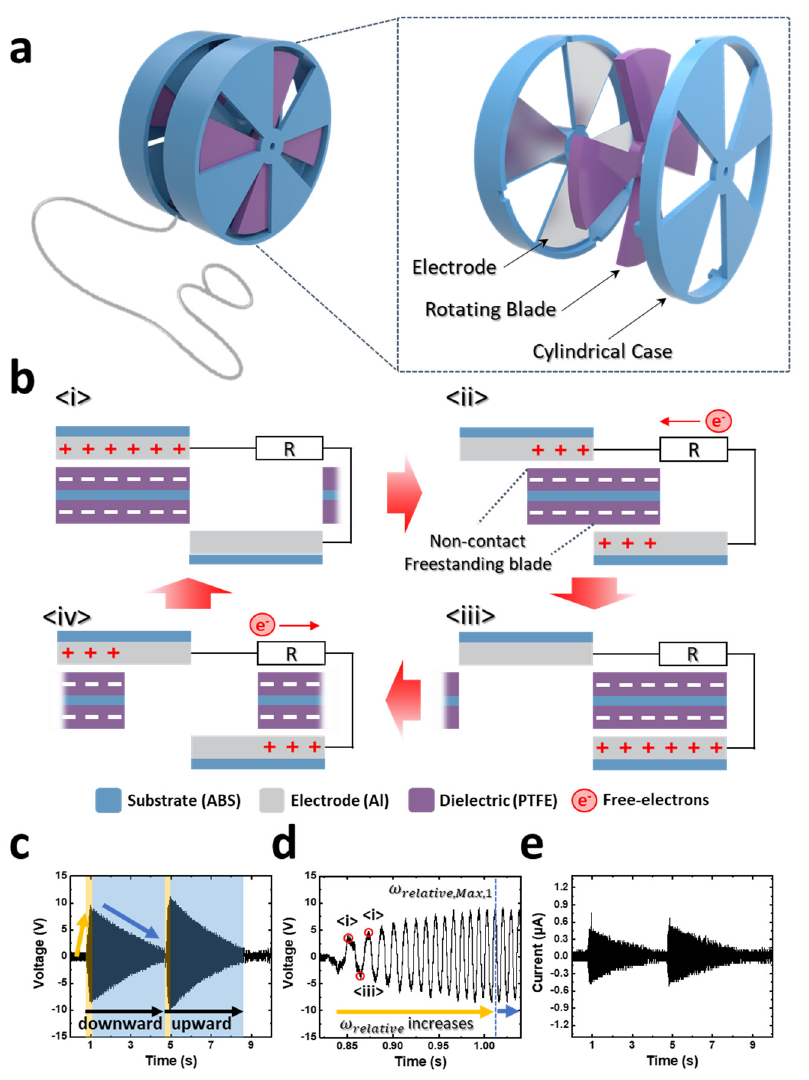
Figure 1. Yo-Yo-inspired triboelectric nanogenerator (Y-TENG) ( a ) Schematic illustration of Y-TENG; ( b ) working mechanism for electricity generation; ( c ) voltage output plot; ( d ) magnified voltage output plot corresponding to the first yellow region in Figure 1c; ( e ) current output plot.